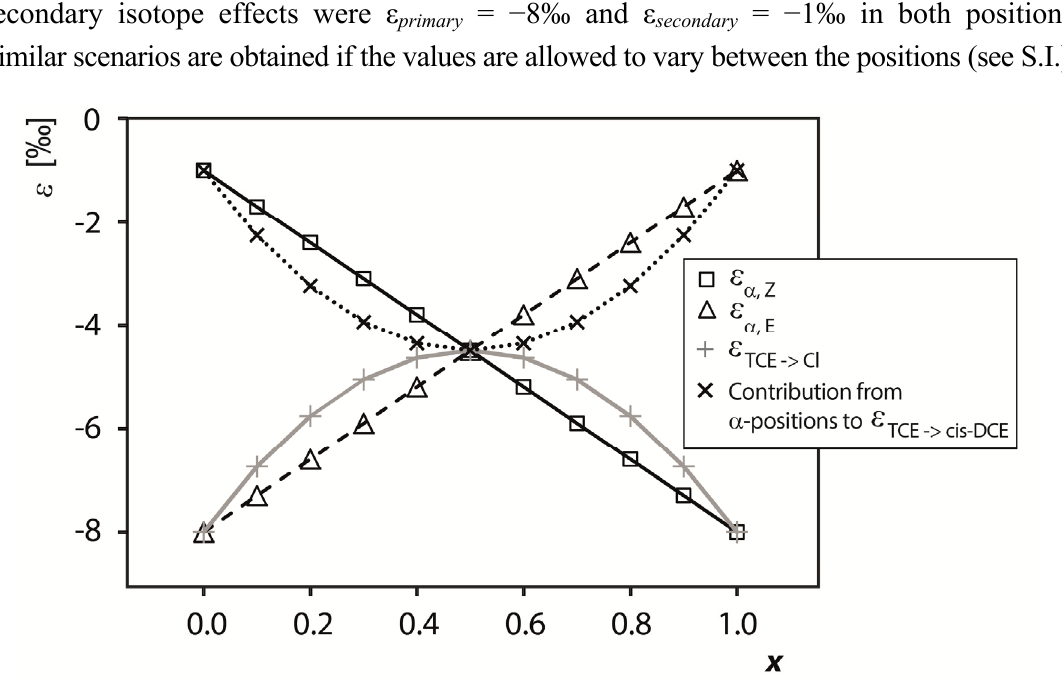
, ε , ε and ε in α , E α , Z TCE->chloride TCE->cis-DCE reacting to Cl − . Assumed values for primary and α , E = − 8‰ and ε = − 1‰ in both positions. primary secondary